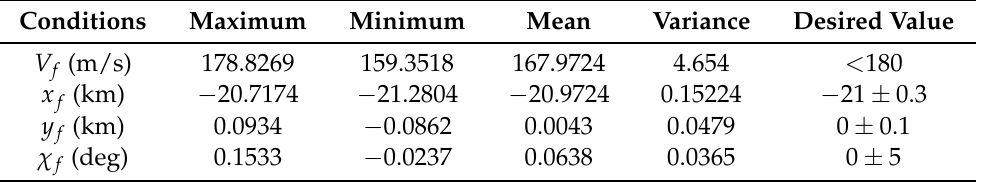
Table 2. TAEM terminal conditions in Monte Carlo